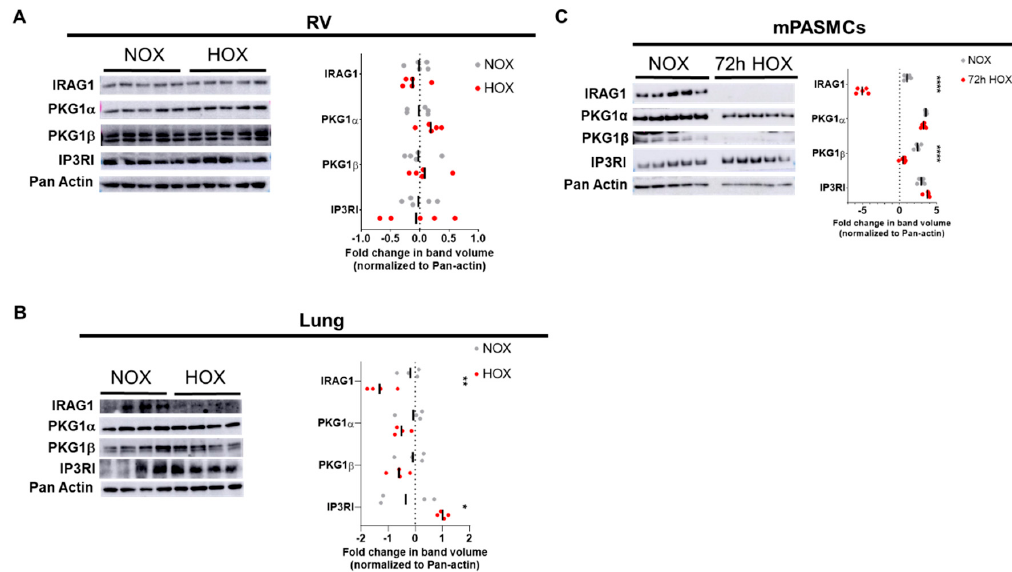
Figure 1. IRAG1 is downregulated in hypoxic mice lungs and isolated mice pulmonary arterial smooth muscle cells under hypoxic condition. ( A , B ) Western blots of protein lysates isolated from normoxic and hypoxic mice right ventricles ( A ) and lungs ( B ). Representative blot pictures are on the left and subsequent lognormal values of densitometry quantification are on the right. ( C ) Smooth muscle cells isolated from mice pulmonary arteries were cultured either in normoxia or hypoxia (1% O 2 ) for 72 h. Representative western blot pictures of protein lysates from these cells are on the left and subsequent lognormal values of densitometry quantification are on the right. Densitometry was performed in the same blot pictures as presented here and n number corresponds to different animals in the same experiment. Number of animals used: ( A ) Right ventricles from five normoxic and five hypoxic WT mice; ( B ) lungs from four normoxic and four hypoxic WT mice; ( C ) mPASMCs isolated from five wildtype (WT) mice. Primary antibodies used in western blots were IRAG1, PKG1 α , PKG1 β , and IP 3